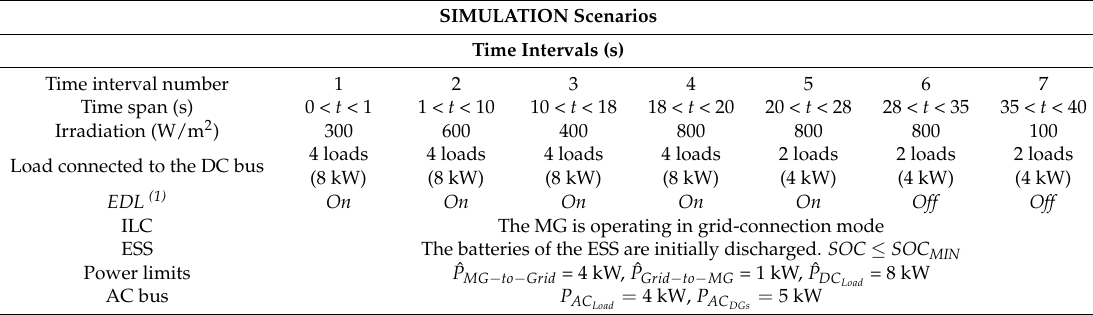
Table 3. The simulation scenarios of the